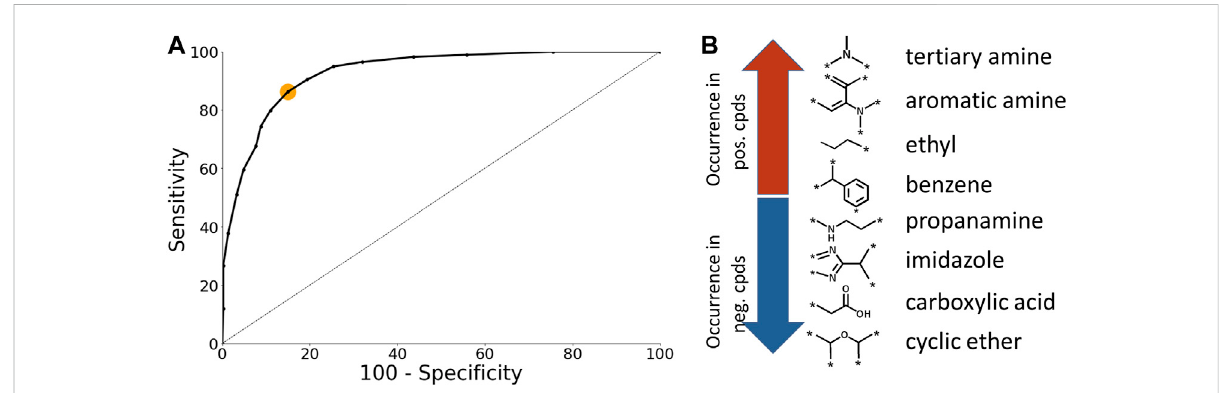
FIGURE 3 Case Ultra model analysis. (A) ROC plot of the BBB model. The orange dot corresponds to the optimal classi fi cation threshold (B) Selected examples of chemical fragments with highest number of positive and negative